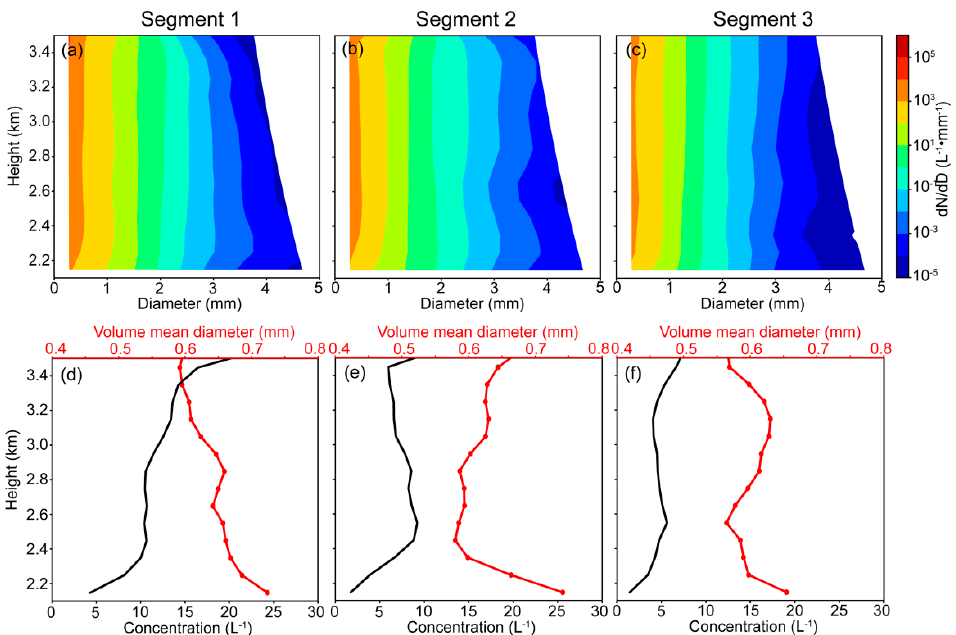
Figure 5. ( a − c ) Drop size distributions and ( d − f ) profiles of drop concentration (black) and volume Figure 5. ( a – c ) Drop size distributions and ( d – f ) profiles of drop concentration (black) and volume mean diameter (red) below the melting layer for the three precipitation segments. mean diameter (red) below the melting layer for the three precipitation